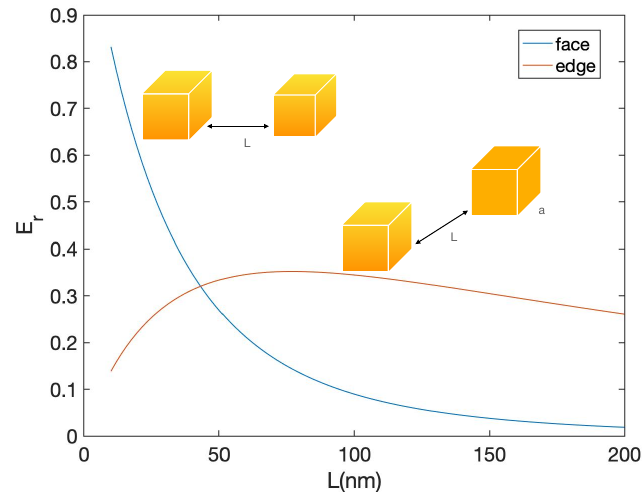
Figure 4. Energy ratio, E r between two cubes facing each other and for two tilted cubes, as a function of the separation L . The nanocubes have dimensions a = b = c = 80